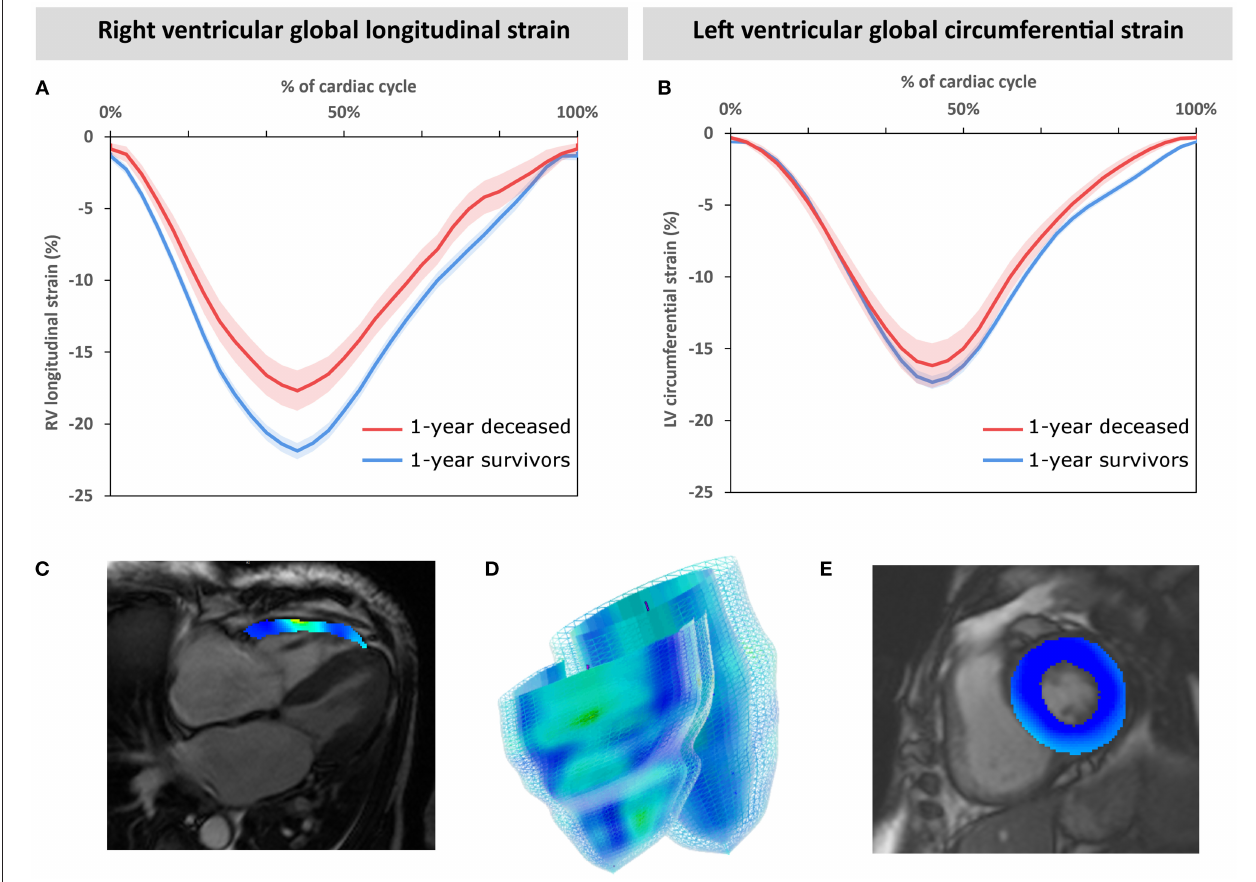
FIGURE 2 | Mean global strain curves of the cohort grouped by 1-year mortality. Individual global strain curves of the entire cohort are aligned at peak systolic strain and averaged in groups according to 1-year mortality. Mean and standard error of the mean are displayed for right ventricular longitudinal strain (A) and left ventricular circumferential strain (B) . Exemplary cardiac magnetic resonance images in end-systole with color-coded strain overlay (C, E) and a 3D model (D) are